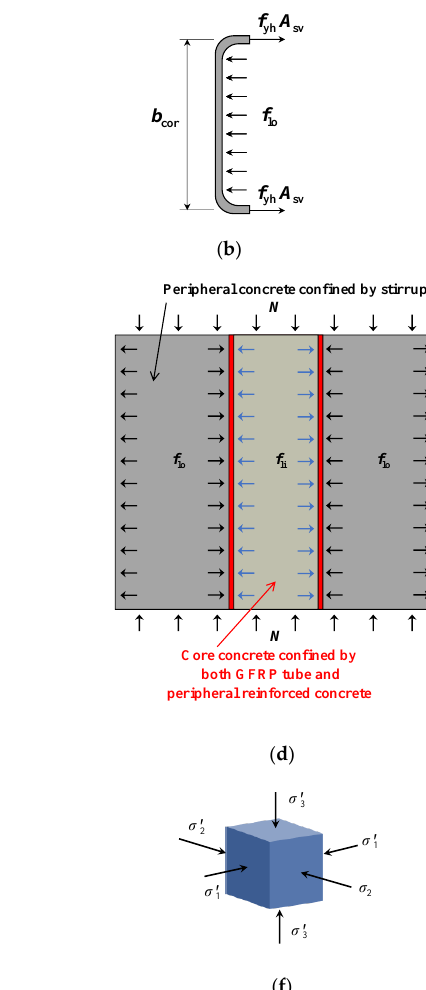
Figure 19. The stress states of different parts: ( a ) Concrete constrained by GFRP tube. ( b ) Concrete constrained by stirrup. ( c ) The cross-section of EGCSSCs. ( d ) The profile of EGCSSCs. ( e ) The element of GFRP tube. ( f ) The element of core and peripheral concrete . In summary, the N us increased with the increase in f cc , f co , t gfrp , ρ s and α , and µ de- creased with the increase in f cc and f co . The reasons for the above changes in the N us and µ are as follows. With the increase in f cc and f co , the load-carrying capacity of the specimens increased while the ultimate compressive strain and transverse deformation capacity of the concrete decreased, which made the restraint effects of the GFRP tube and stirrups decrease [13,37], resulting in the increase in the N us and the decrease in the µ . The core and peripheral concrete were constrained by the GFRP tube and stirrups, respectively, and with the increase in t gfrp , ρ s and ρ s , the lateral deformation of the core concrete and the development of internal cracks became smaller, and the compressive strength of the core and peripheral concrete increased, thereby the N us and µ were improved [9,37,43,44]. Moreover, the change in ρ v had little effect on the N us and µ ; this was due to the small change in the cross-sectional area of the steel bars. 6. Force Mechanism of EGCSSCs The relationship between the longitudinal compressive strain ( ε 1 ) and the circum- ferential strains of EGCSSCs is shown in Equation (6) [39,47], and ε 1 increases with the increase in the axial compression ( N ).